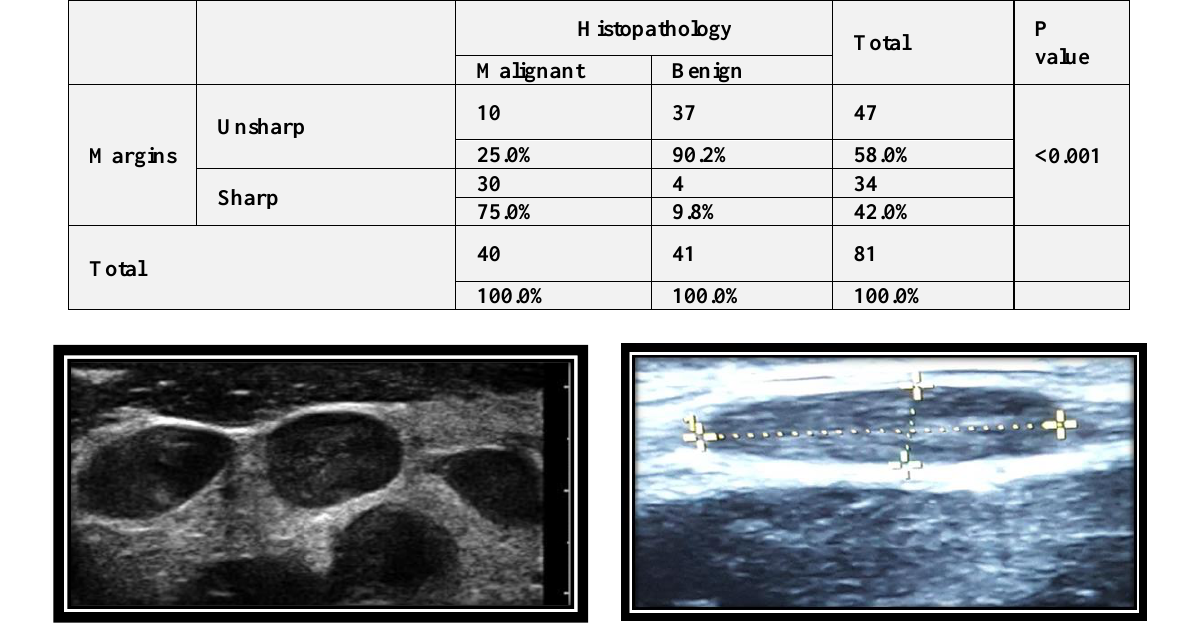
Table (10):- Association between histopathological findings and borders of L.Ns